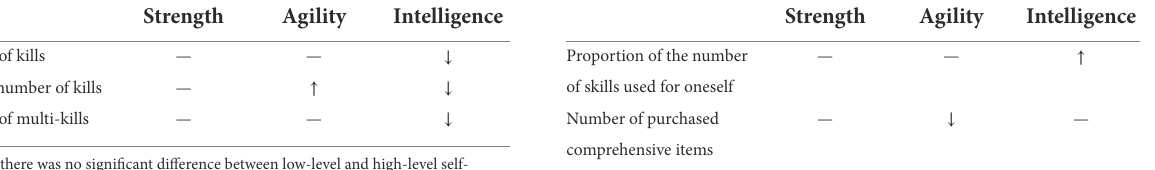
TABLE 5 Changes in task performance-related behavior indicators as players’ self-regulation increased. Strength Agility